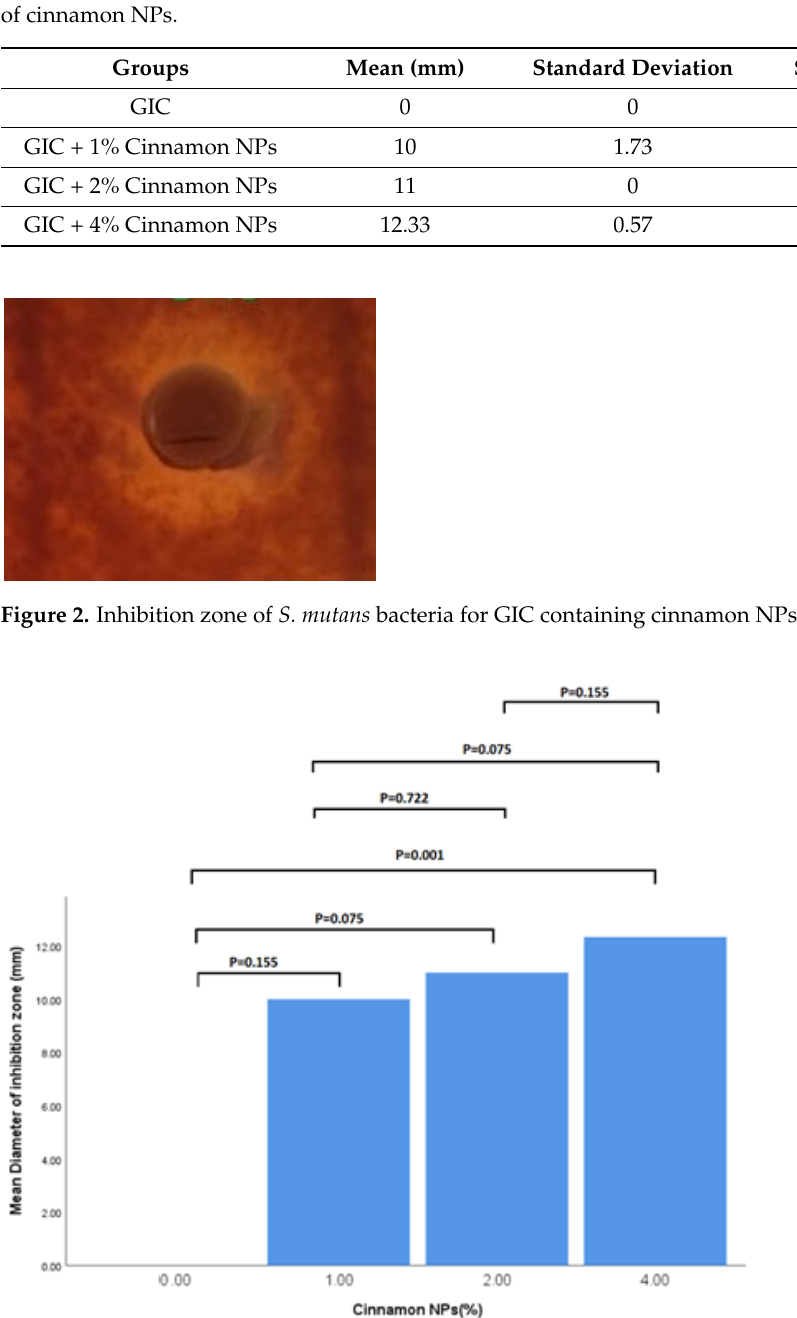
Figure 3. The result of the pairwise comparison test on the groups for cinnamon NPs addition into the GIC .